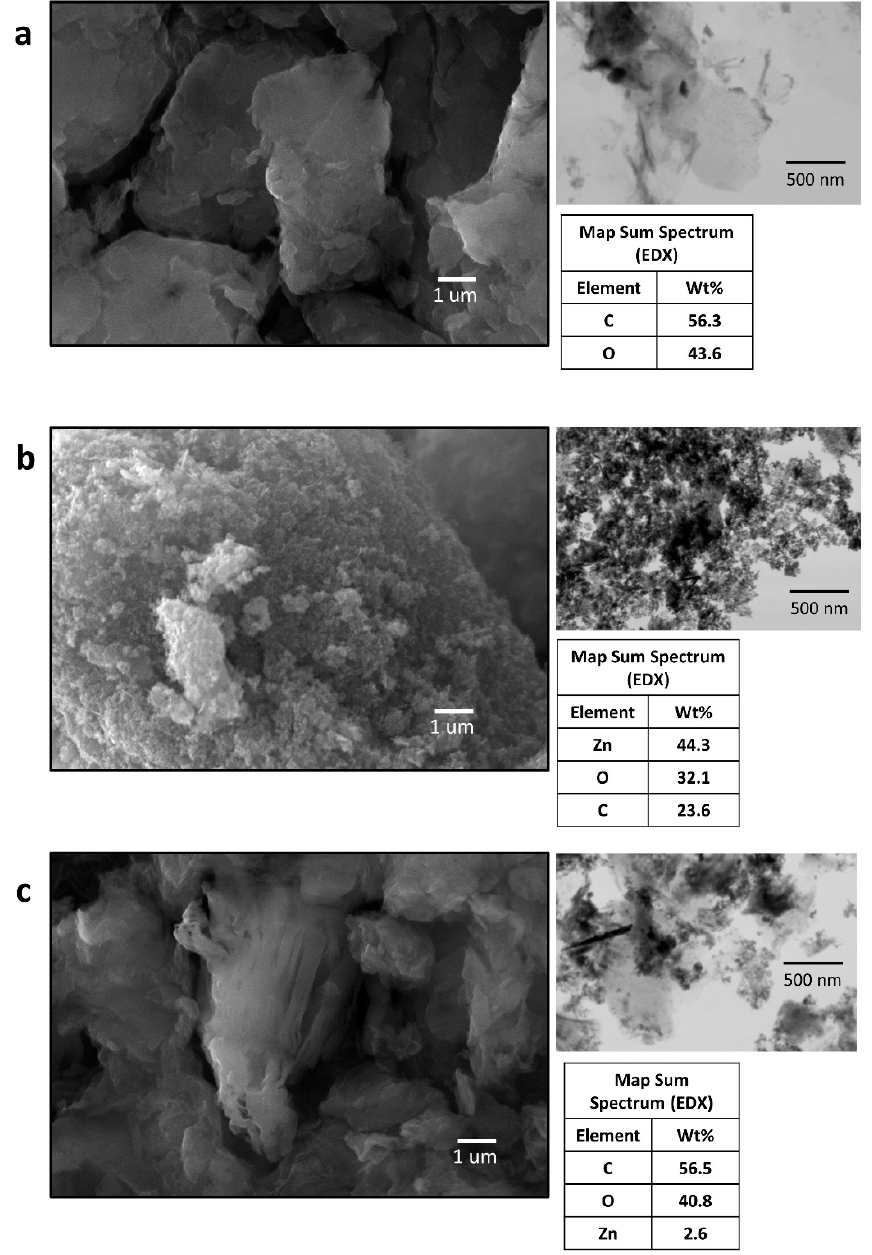
Figure 2. Scanning electron microscopy coupled with energy-dispersive X-ray spectroscopy (SEM-EDX) and scanning transmission electron microscopy (STEM) of ( a ) GO, ( b ) ZnO and ( c ) GO /